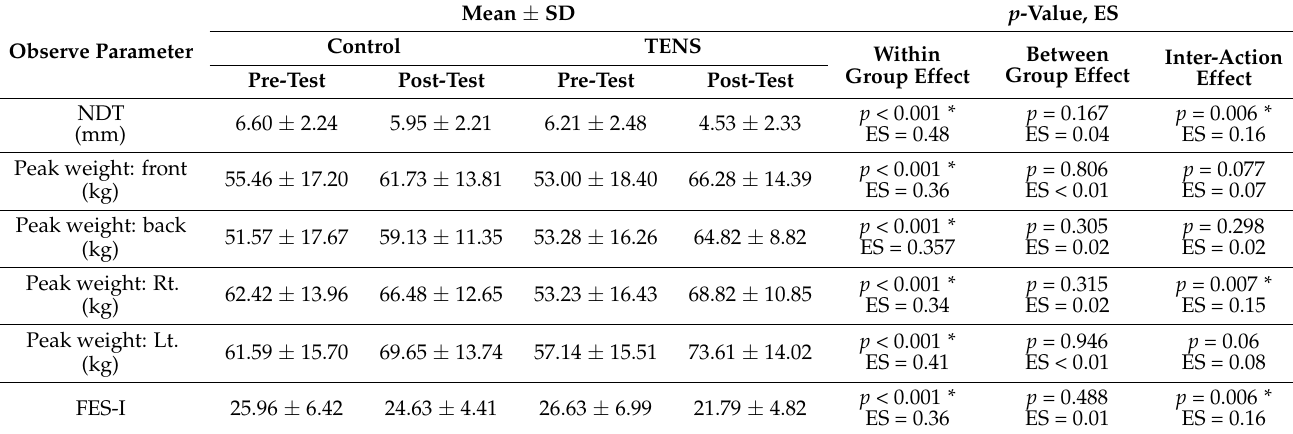
Table 1. Mean and SDs of the NDT, balance, and FES-I before and after 4 weeks of TENS and CON interventions. Mean ± SD p -Value, ES Control TENS Within Observe Parameter Between Inter-Action Group Effect Group Effect EffectPre-Test Post-Test Pre-Test